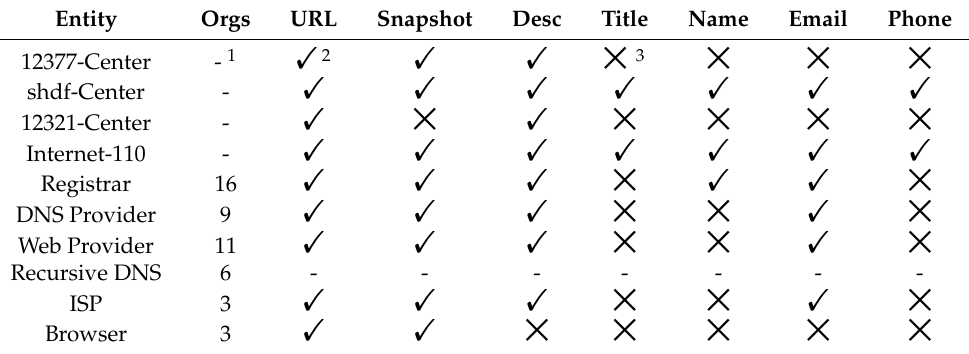
Table 2. Overview of what are included in the evidence reported to the